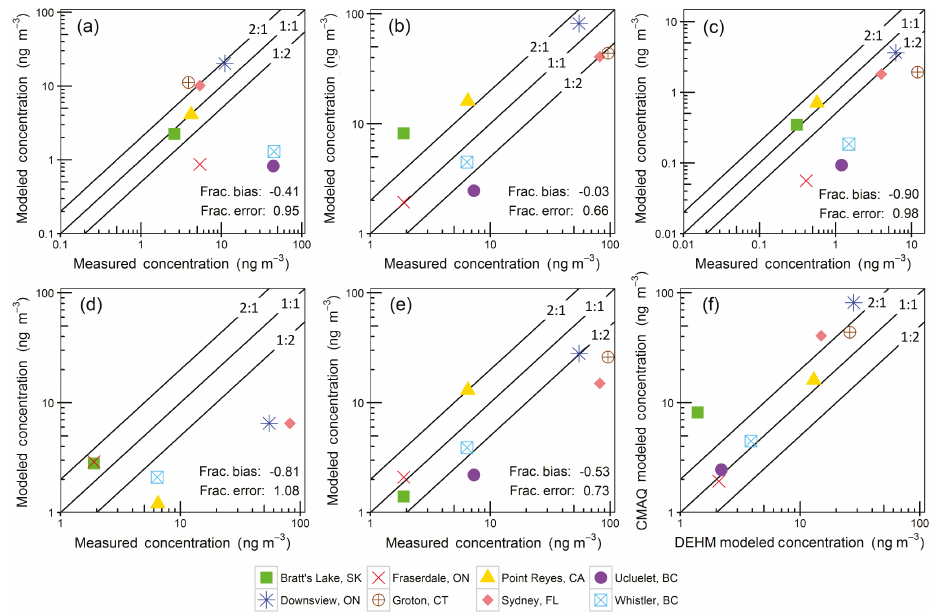
Figure 5. Plot (a) shows CMAQ D 4 , (b) CMAQ D 5 , (c) CMAQ D 6 , (d) BETR D 5 , and (e) DEHM D 5 modeled concentrations compared to Genualdi et al. (2011) measurements. Plot (f) compares modeled CMAQ D 5 versus DEHM D 5 concentrations. CMAQ model results are the April averaged concentrations while BETR and DEHM model results are from Genualdi et al. (2011) and represent the same period as the measurements. Model resolution was 36km for CMAQ, 150km for DEHM, and 15 ◦ for BETR. Table 2. Toronto cyclic siloxane comparison between the CMAQ model and previous studies. Reported are the mean concentrations with ranges in